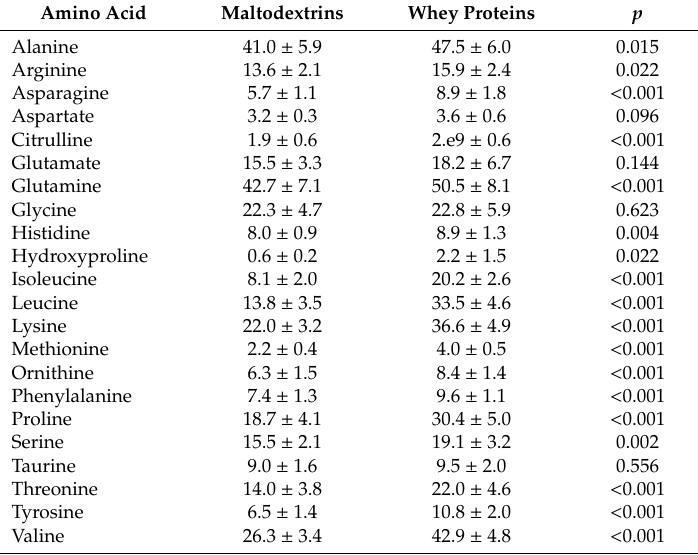
Figure 3. Changes of total amino acids (TAA) (top panel) and branched-chain amino acids (BCAA) (bottom panel) in obese subjects after the intake of a drink (completely within 15 min starting at T0), containing whey proteins or maltodextrins. Values (curves on the left side and areas under the curve from T0 to T120 [AUC T0 − T120 ] on the right side) are expressed as mean ± SD. The number of subjects was 8. ○ p < 0.05 vs. the corresponding T0 value; * p < 0.05 vs. the corresponding value of the maltodextrins-treated group. One- or two-way ANOVA with repeated measures (with the single factor of group or two factors of time and group, and the interaction time × group, respectively), followed by the post hoc Tukey’s test, was used, when appropriate. Table 1. Post-prandial responses in circulating levels of amino acids (expressed as AUC T0 − T120 [ × 10 3 µ M × min]) after ingestion of a beverage containing whey proteins or maltodextrins in obese subjects (at T0).